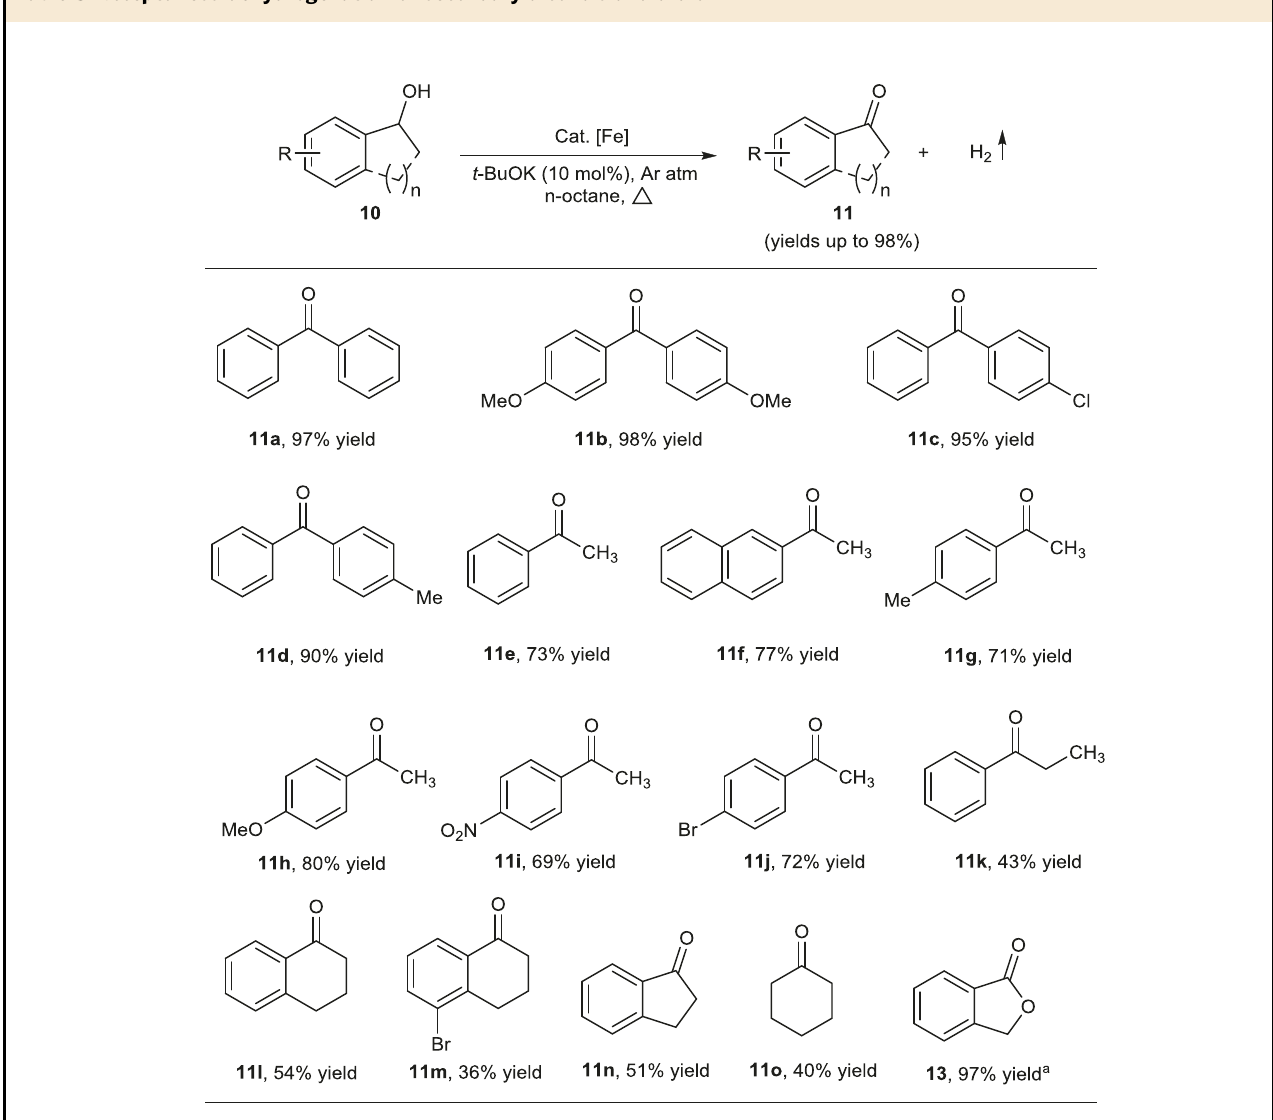
Table 5 Acceptorless dehydrogenation of secondary alcohols and a